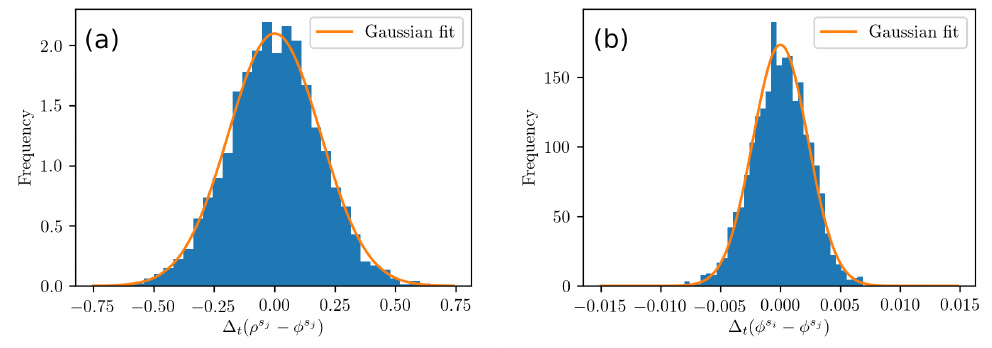
Figure 7. The distribution of the combination of measurements of Equations (17) and (21), in ( a ) and ( b ), testing whether modeling DLL and PLL errors, respectively, as Gaussian noise is appropriate. Data are from Figures 5e and